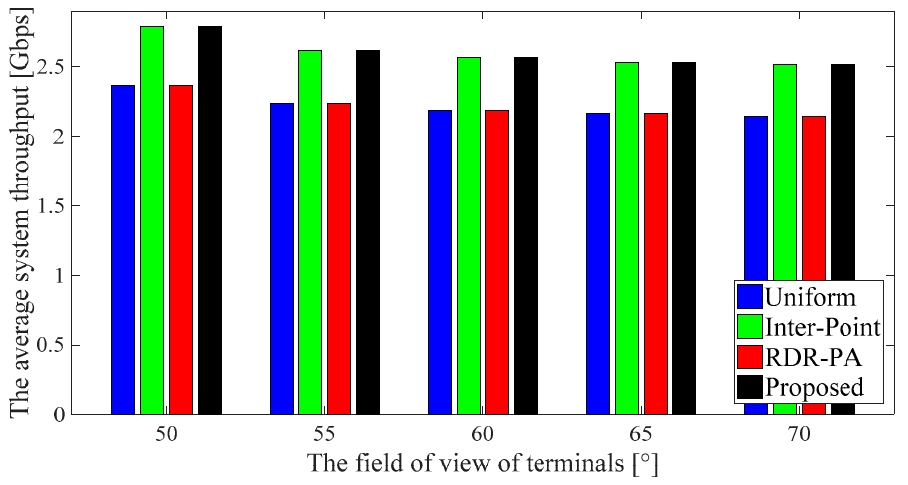
Figure 11. The average system throughput versus the field of view.